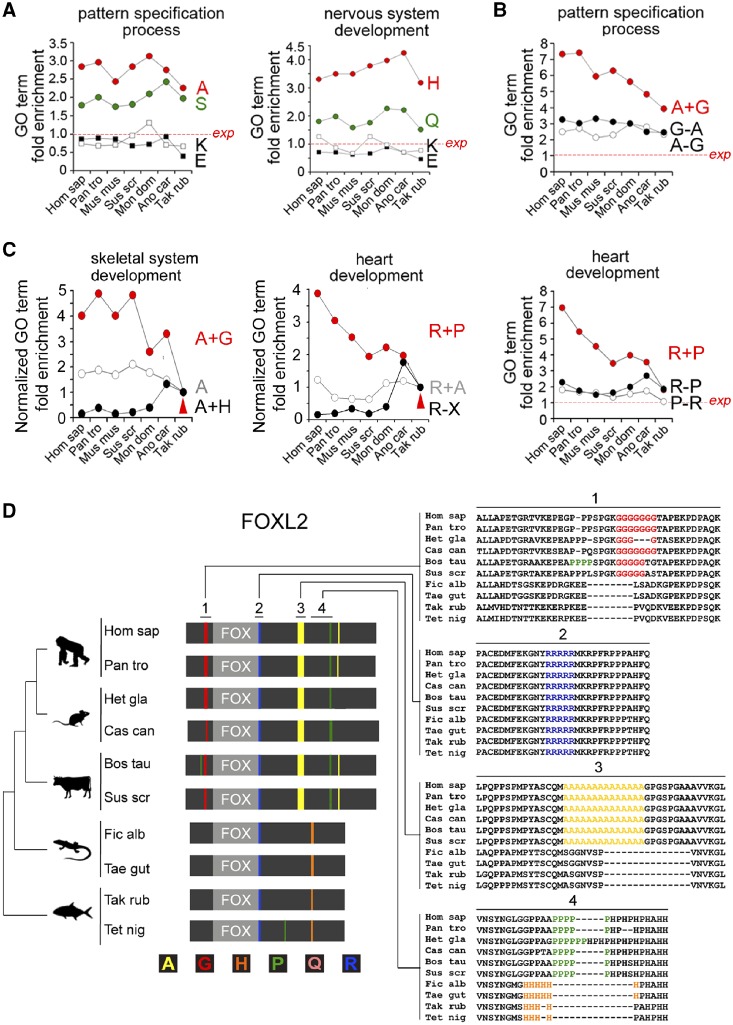
—Dynamically evolving associations of AARs with DP functions. (A–C) Graphs showing the relative fold enrichment throughout vertebrate phylogenesis of the indicated GO terms in the protein groups containing the indicated AARs, or their combinations, in the species on the X axis, ranging from H. sapiens (Hom sap) to T. rubripes (Tak rub). Other species name abbreviations are indicated in the Materials and Methods section. (A) The GO terms “pattern specification process” and “nervous system development” are stably overrepresented throughout vertebrate phylogenesis in protein groups containing certain AARs (e.g., polyA/H/Q/S) but not others (e.g., polyE/K). (B) Graphs showing the fold enrichment throughout vertebrate phylogenesis of the GO terms “skeletal system development” (upper) and “heart development” (lower) in proteins containing polyA±G or polyR±P, respectively. (C) Graphs similar to those in (B), showing from Takifugu to Homo the progressively increasing overrepresentation of the GO terms “skeletal system development” and “heart development” in the polyA+G and polyP+R protein groups, respectively, in comparison with other protein groups bearing the same repeats as such or in other combinations. Values are normalized to Tak rub (arrowhead). (D) Schematic representation (gray bars) of the FOXL2 protein and of some of its orthologs in species belonging to major vertebrate taxa (i.e., Primates, Rodentia, Laurasiatheria, Sauropsida, and fishes). AARs are represented by colored bars according to the color coding below the bars. The FOX domains are represented in light gray. Regions of interest (marked as 1, 2, 3, 4) of the amino acid sequence alignment of the orthologs are shown on the right.